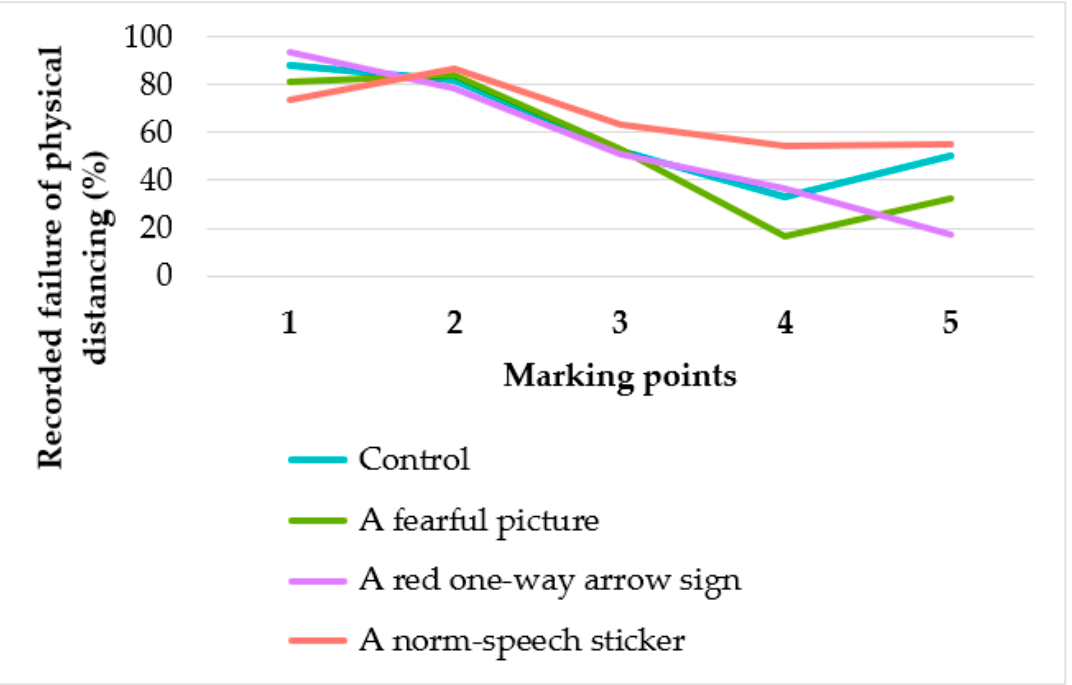
Figure 2. The percentage of recorded failures of physical distancing according to the marking point.